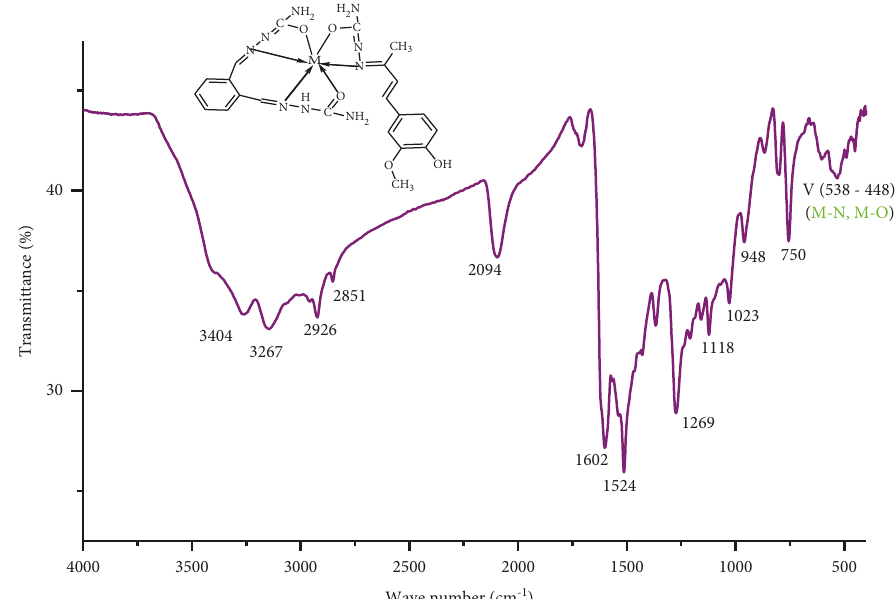
Figure 5: The FT-IR spectra of [Cu( L